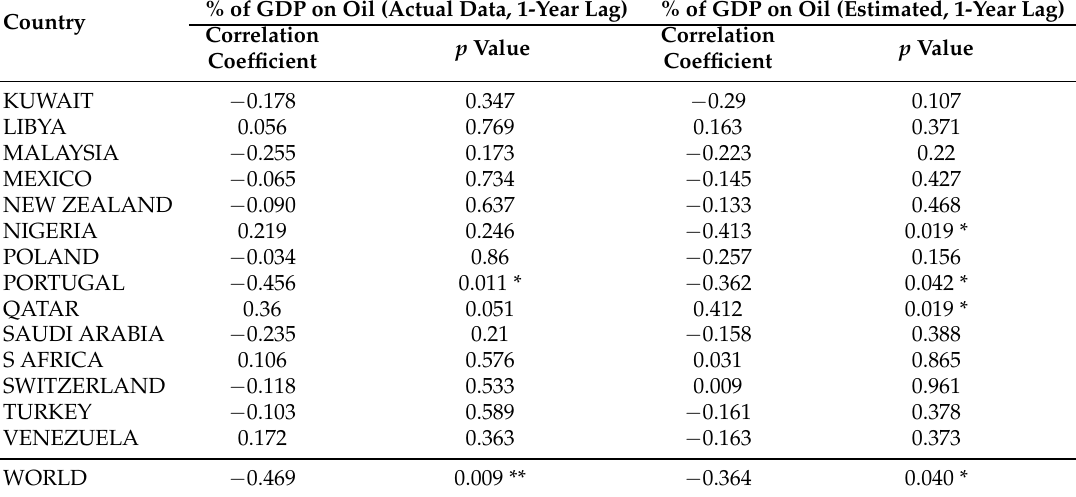
Table 4. The correlation between 1-year lagged change in total factor productivity (measured as logarithmic differences) and f e ,GDP on oil only for both the TED TFP and OECD MFP